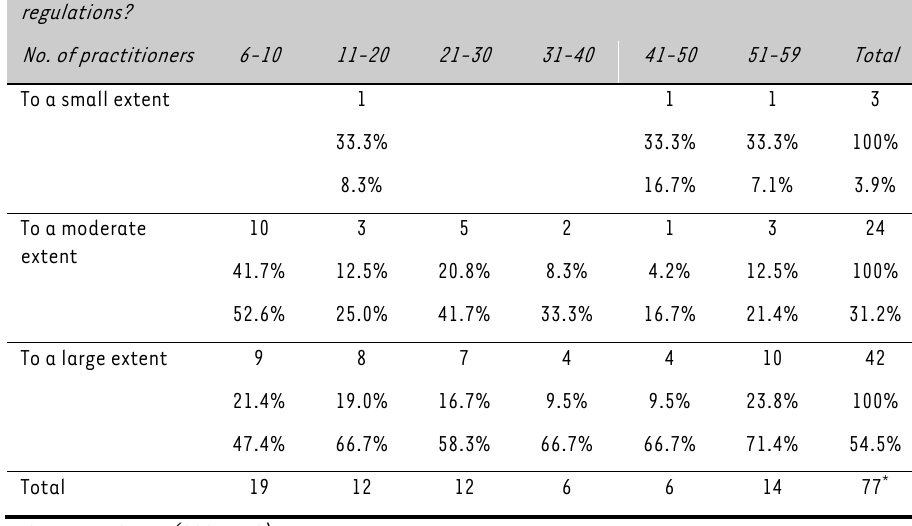
TABLE 4: Research results for question 2 Question